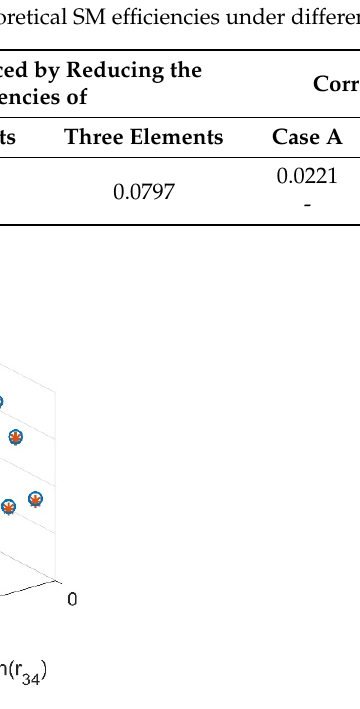
Figure 2. SM efficiency as a function of correlations in a 4 × 4 MIMO system. Table 1. RMSEs (dB) between simulated and theoretical SM efficiencies under different conditions.